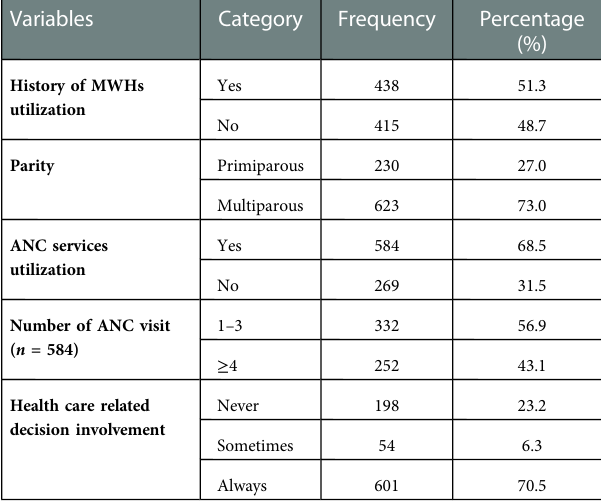
TABLE 2 Reproductive and maternal health service-related characteristics of study participants in Dega Damot district, northwest Ethiopia, 2021 ( n =853).